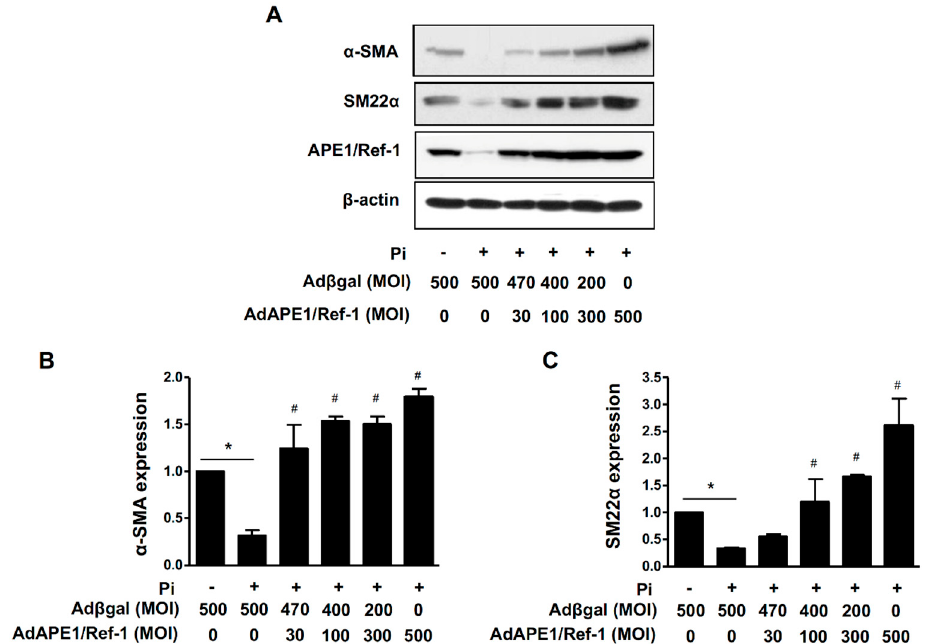
Figure 7. APE1/Ref-1 suppresses inorganic phosphate (Pi)-induced loss of the vascular smooth muscle cell phenotype. ( A ) Representative Western blot. ( B , C ) Quantified levels of α -SMA ( B ) and SM22 α ( C ). Cells were transfected with APE1/Ref-1 at multiplicities of infection from 30 to 500 and exposed to Pi (5 mM) for 6 days. α -SMA and SM22 α protein levels were analysed by Western blot. Each bar represents the mean ± standard error of the mean ( n = 5). * p < 0.05 vs. control; # p < 0.05 vs. Pi alone by one-way ANOVA.